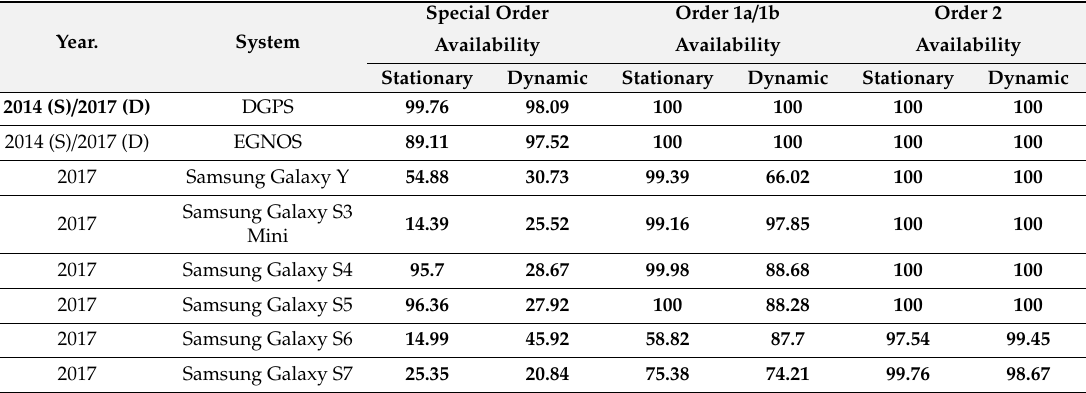
Table 4. A summary of the availability factor values, determined for the DGPS and EGNOS systems, as well as multi-GNSS receivers in the context of minimum positioning requirements determined for four IHO orders. The measurements relate to stationary and dynamic